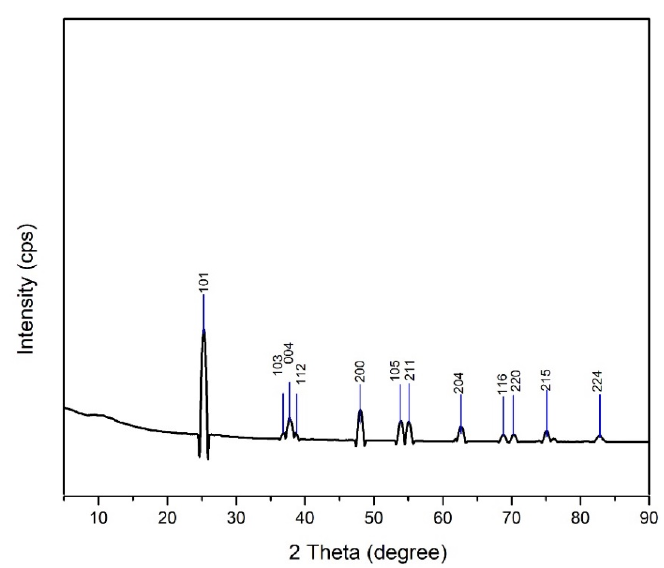
Figure 3. TiO 2 nanoparticle diffractogram.